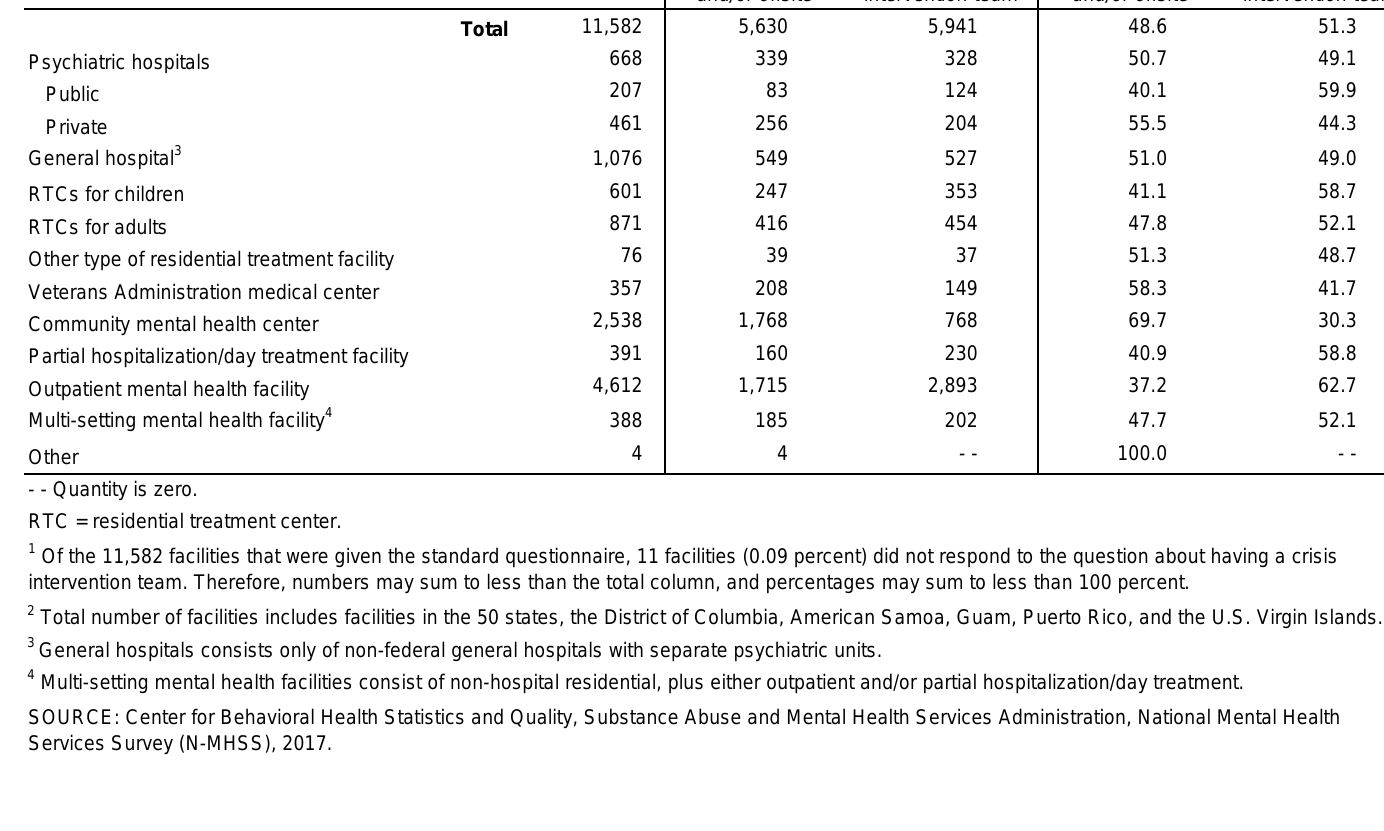
Table 2.8. Mental health treatment facilities that employ a crisis intervention team, by facility type: Number and percent, 2017